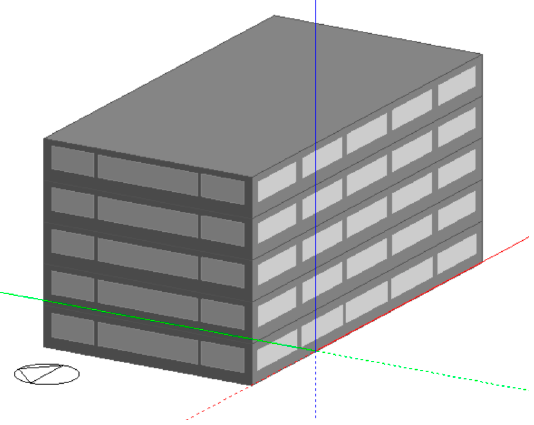
Figure 3. Overall building view.